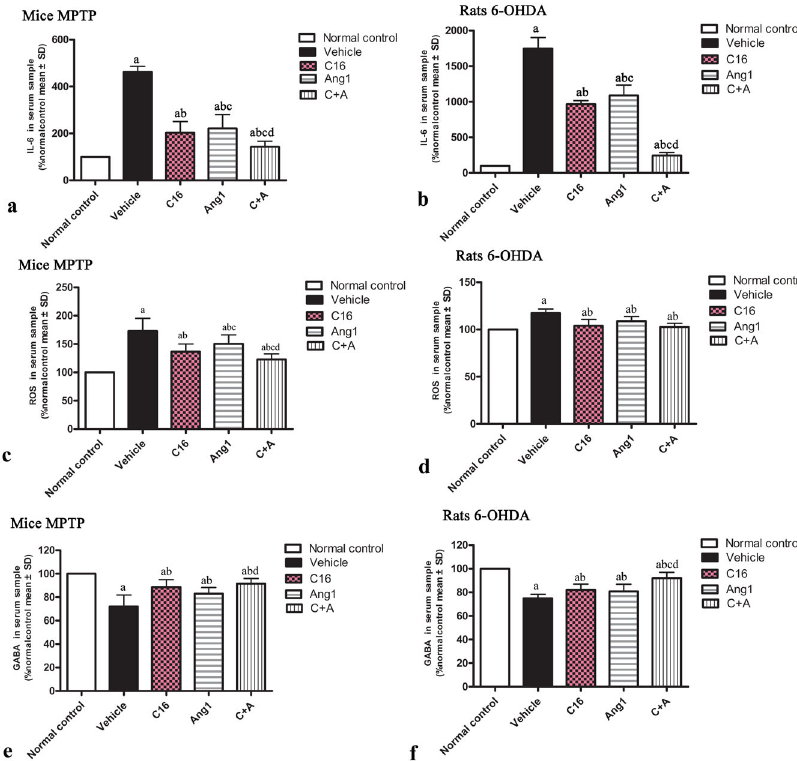
Fig. 3 C16 in combination with Ang-1treatment reduced the expression of proin fl ammatory mediators. a – d Pro-in fl ammatory mediators, including IL-6 ( a , b ) and ROS ( c , d ) were upregulated in MPTP-injected mice ( a , c ) and 6-OHDA-infused rats ( b , d ). Treatment with C16 or Ang-1, and especially C16 plus Ang-1 signi fi cantly reduced the expression of IL-6 and ROS. e , f The expression level of GABA was decreased in MPTP- injected mice ( e ) and 6-OHDA-infused rats ( f ), but elevated following treatment with C16, Ang-1, or C16 plus Ang-1. The combined treatment showed the most potent effect. The expression of IL-6 ( a , b ), ROS ( c , d ), and GABA ( e , f ) in the serum samples were detected by ELISA. a p < 0.05 versus the normal control group; b p < 0.05 versus the vehicle group; c p < 0.05 versus the C16-treated group; d p < 0.05 versus the Ang-1- treated group. IL-6, interleukin-6; ROS, reactive oxygen species; MPTP, 1-methyl-4-phenyl-1,2,3,6- tetrahydropyridine; 6-OHDA, 6- hydroxydopamine; C16, peptide (KAFDITYVRLKF) that can selectively bind integrin α ν β 3 ; Ang-1, angiopoietin-1; GABA, γ -aminobutyric acid; ELISA, enzyme-linked immunosorbent